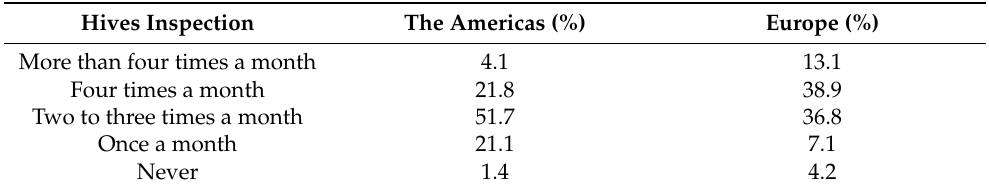
Table 1. Number of inspections during the active season both in the Americas and in Europe. The values are expressed in percent (%). Columns exceed 100% due to